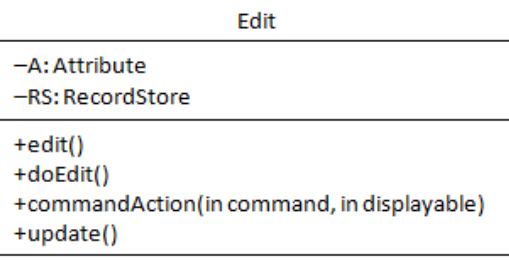
Figure 2. One-function structure for Edit [40].